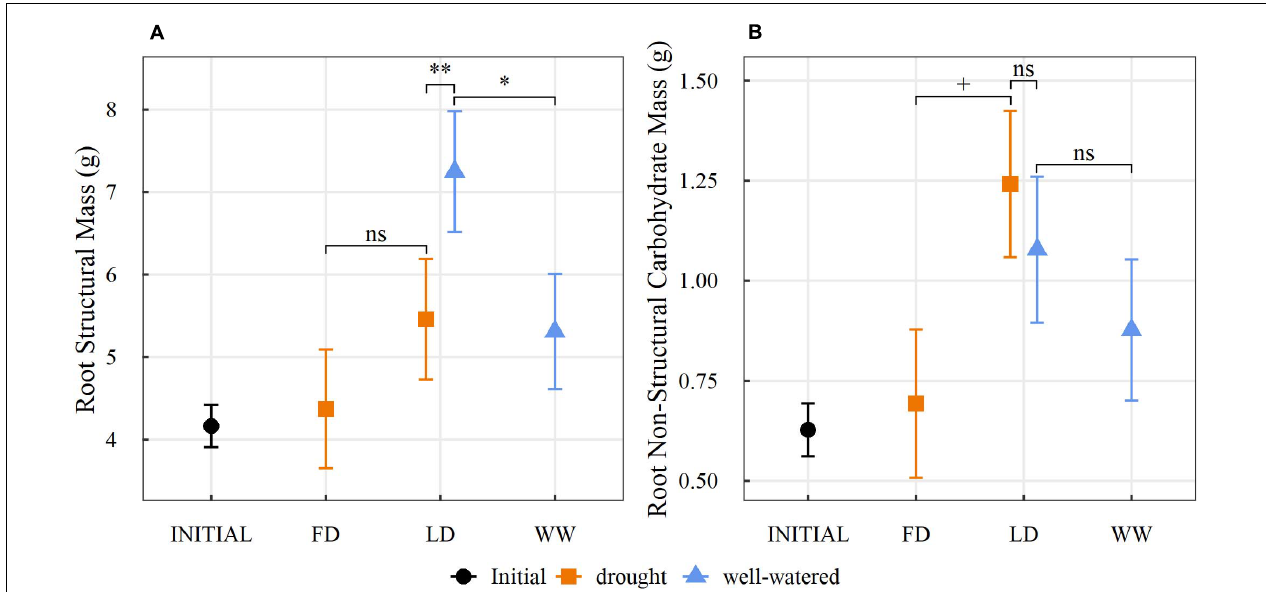
FIGURE 4 | Estimated marginal mean ( ± 1 standard error) of (A) root structural mass (g) (the non-reserve portion of dry root mass) and (B) root non-structural carbohydrate mass (g) within the split root system for saplings prior to (INITIAL) and after the three watering treatments (FD: full drought, LD: localized drought, WW: well-watered) (orange: dry, blue: well-watered). Statistical differences between the three planned comparisons (FD vs. LD-dry, LD-dry vs. LD-wet, WW vs. LD-wet) are indicated by + for p < 0.1, * for p < 0.05, ** for p < 0.01 and ns for no significance ( n = 29; α =